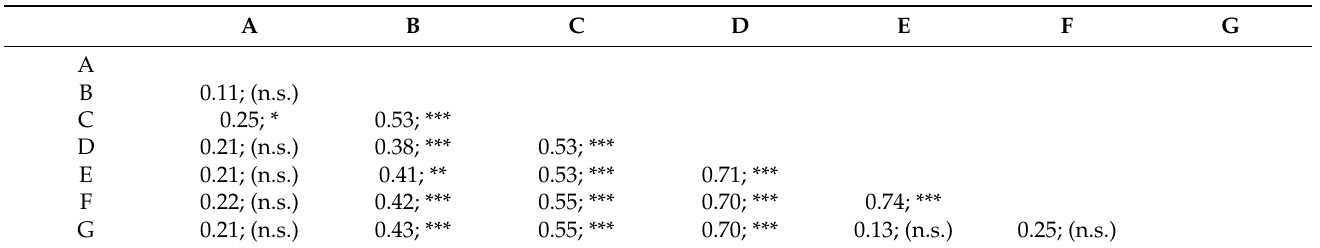
Table 4. Association between competencies associated with research methodology and the reply to